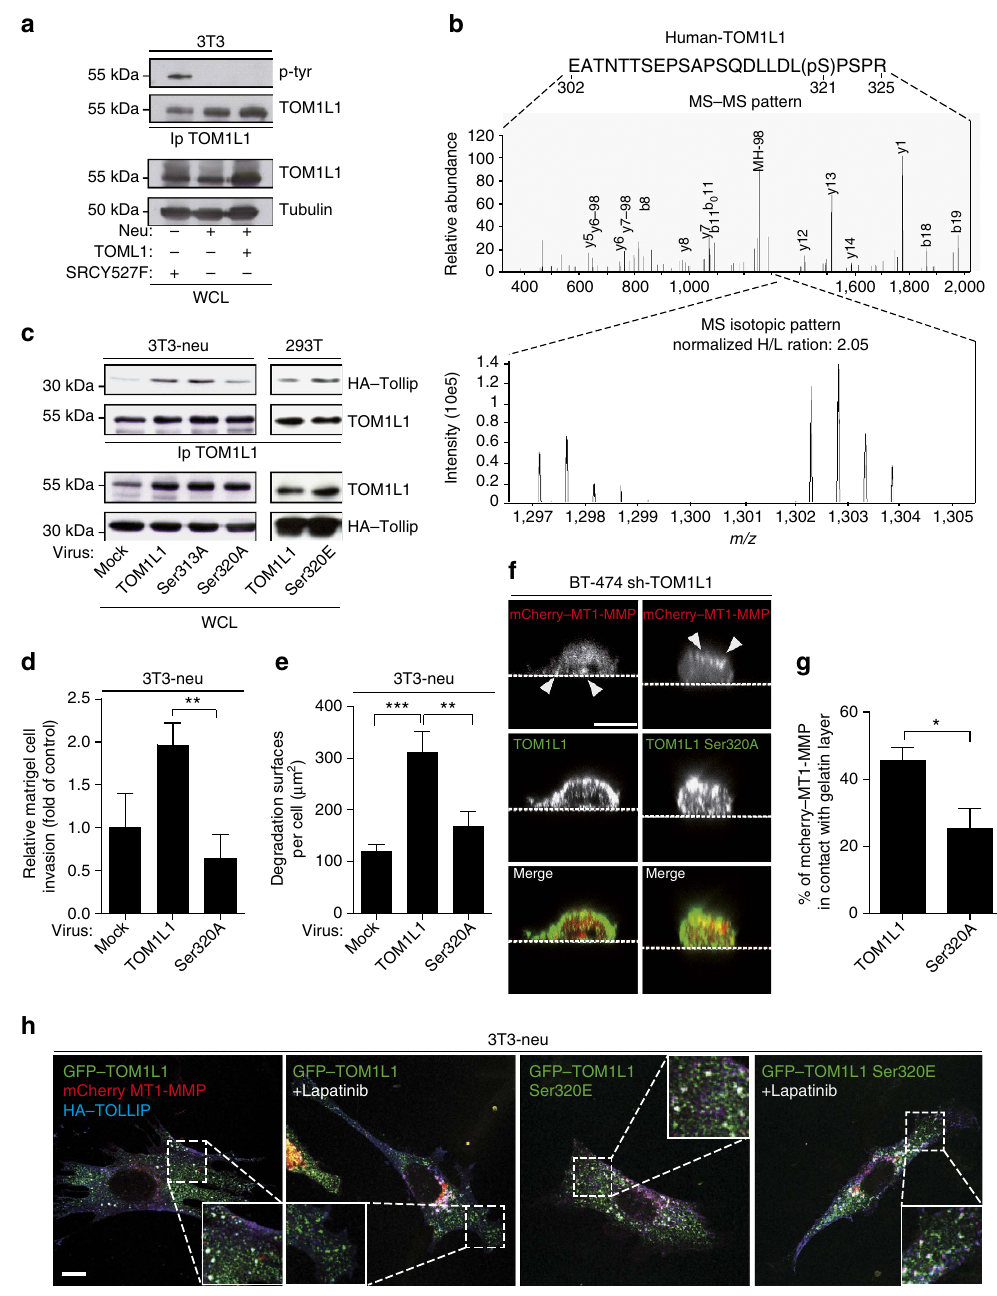
Figure 8 | ERBB2 indirectly promotes TOM1L1-Ser321 phosphorylation for interaction with TOLLIP and MT1-MMP trafficking. ( a ) Lysates from 3T3 cells infected as indicated were immunoprecipitated with an anti-TOM1L1 antibody and immunoblotted to visualize TOM1L1 phosphorylation. ( b ) SILAC mass spectrometry analysis. 3T3-neu cells transfected with GFP–hTOM1L1 were cultured for 2 weeks in medium containing light ( 12 C 6 14 N 4 -Arg and 12 C 14 N 13 C 15 N 13 C 15 N 6 2 -Lys) or heavy ( 6 4 -Arg and 6 2 -Lys) arginines and lysines and treated with 1 m M Lapatinib or not (DMSO) for 3h before lysis. GFP–hTOM1L1 was immunoprecipitated using the GFP-Nanotrap technology then digested using trypsin. The hTOM1L1 peptides phosphorylation was then analysed by mass spectrometry (see Methods for details). Upper panel: fragmentation spectra of the single peptide find phosphorylated (localization on Ser321 with a probability 4 0.75 as calculated by MaxQuant). Lower panel: Heavy/Light SILAC ratio (H/L) for this peptide, traducing the phosphorylation ratio changes between the tested conditions. ( c ) 3T3-neu and 293T cells infected as indicated were transfected with HA–TOLLIP. Lysates were then immunoprecipitated and immunoblotted as shown. ( d ) 3T3-neu cells infected as indicated were seeded in Boyden chambers with matrigel for 24h and cells present in the lower chamber were counted. The histogram shows the invasion ratio normalized to control ( n ¼ 3). ** P r 0.01 (Student’s t -test). ( e ) 3T3-neu cells infected as indicated were cultured on Oregon Green 488 gelatin for 24h to visualize gelatin degradation areas. The quantification (mean ± s.e.m.) of degradation areas per cell is shown ( n ¼ 26-48). ** P r 0.01; *** P r 0.001 (Student’s t -test). ( f ) BT-474 cells infected with TOM1L1 shRNA and transfected with indicated constructs were imaged by confocal orthogonal imaging. Arrowheads show the change of MT1-MMP apico-basal polarity. Scale bar, 10 m m. ( g ) Quantification of f . The fraction of mCherry–MT1-MMP in contact with the gelatin layer was evaluated as in Fig. 5b ( n ¼ 4). Mean ± s.e.m. * P r 0.05 (Student’s t -test). ( h ) 3T3-neu cells transfected with mCherry–MT1-MMP, HA–TOLLIP and GFP–TOM1L1 or the phosphomimetic mutant (S320E) were treated or not with 1 m M Lapatinib for 2h. Localization of colocated spots was visualized by confocal imaging. Insets show higher magnification of the boxed areas. Scale bar, 10 m